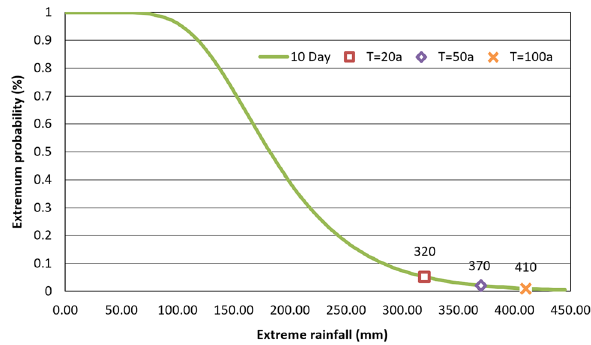
Fig. 6 Distribution of extreme rainfall over a 10-day duration with different return periods for Wanzhou County, Three Gorges Reservoir region. The scale parameter a = 0.02 and the distributed density parameter u = 162.7 in this